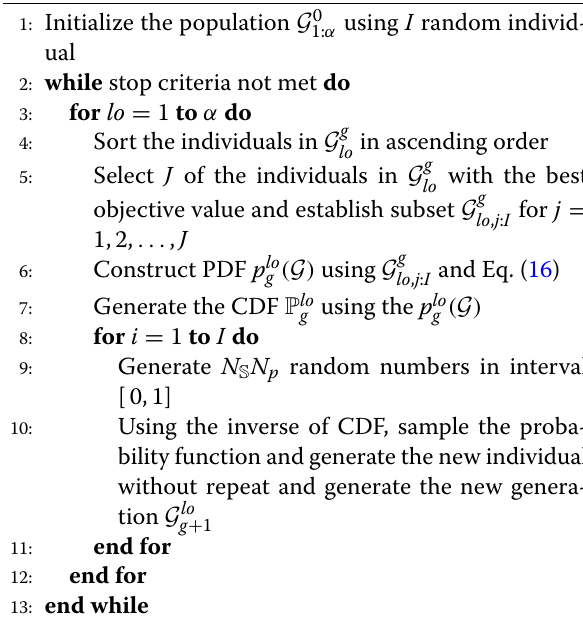
algorithm, we have proposed PCE-based pilot allocation plan. PCE considers α number of points in search space S